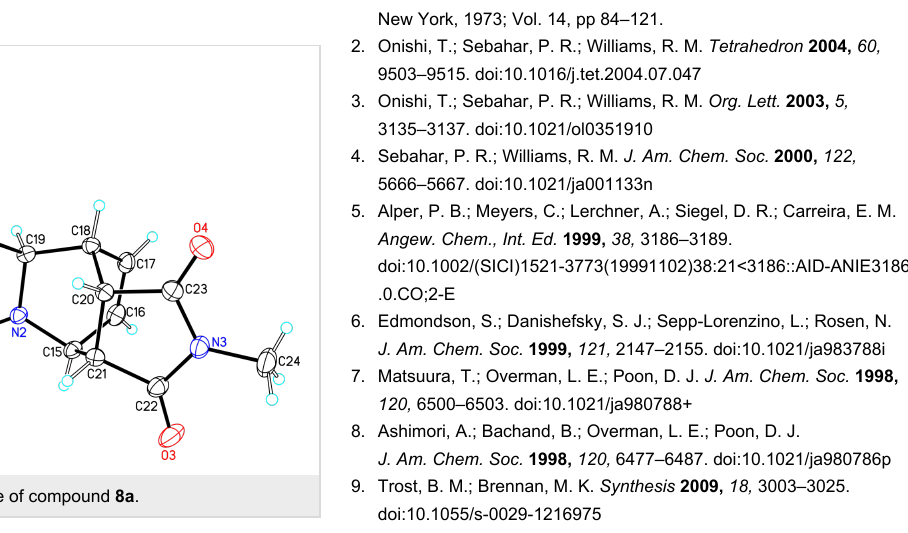
Figure 2: X-ray crystal structure of compound 3d .